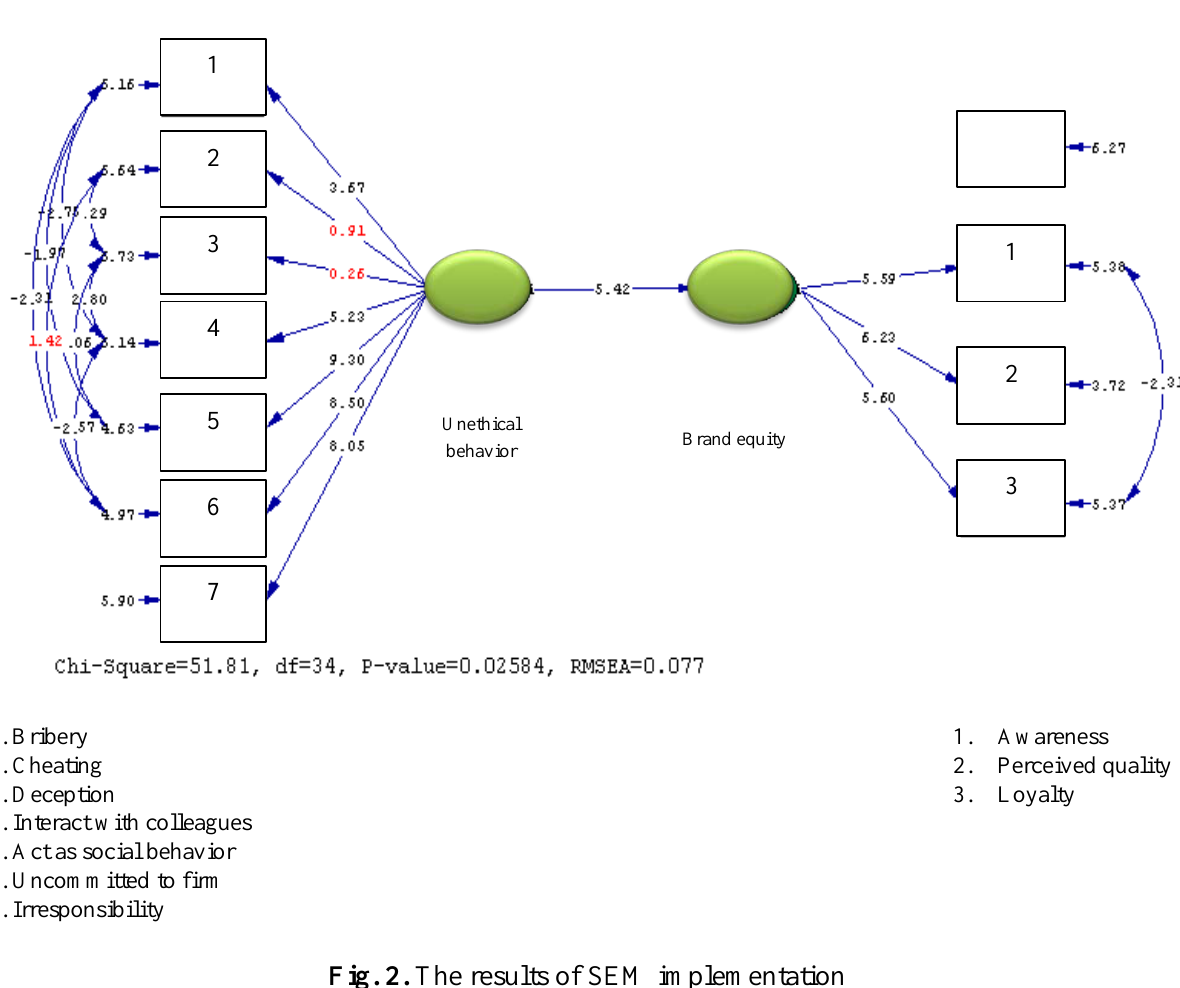
Fig. 2. The results of SEM